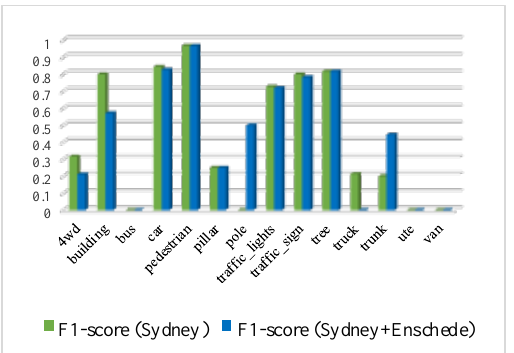
Figure 4. The Precision of Vox-Net classification with and without a complementary dataset.